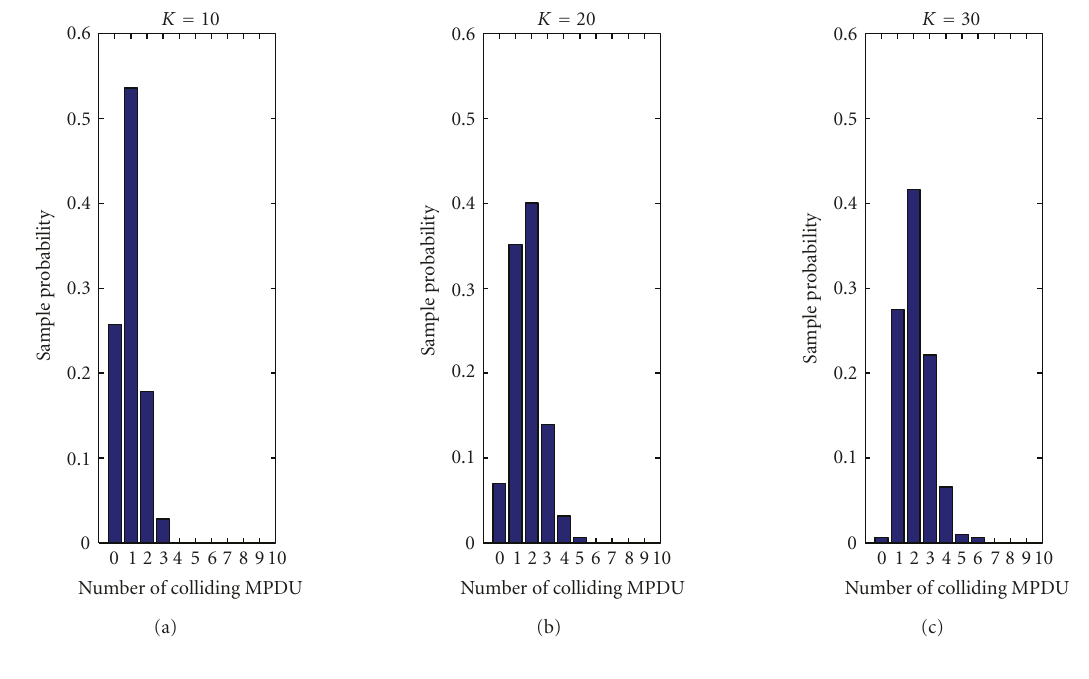
Figure 9: Collision statistics for D = 150 m with the single-cell scenario of Figure 2.